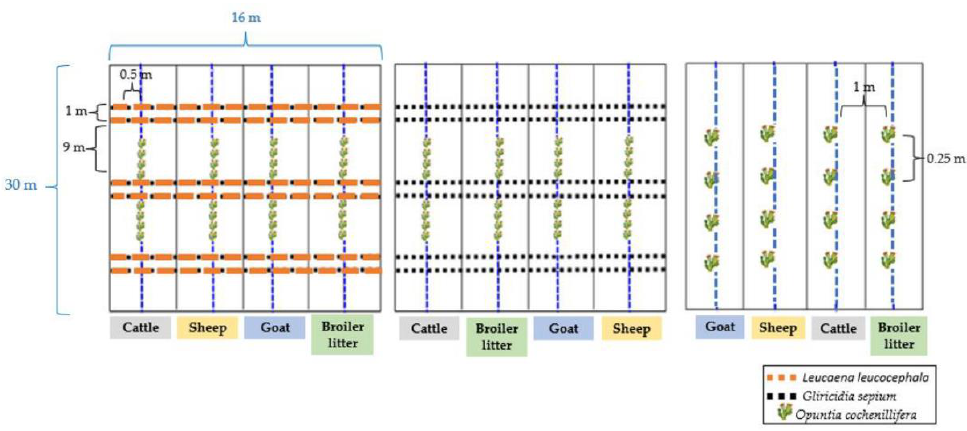
Figure 2. Experimental layout with main plot (cropping system) and subplot (manure source).